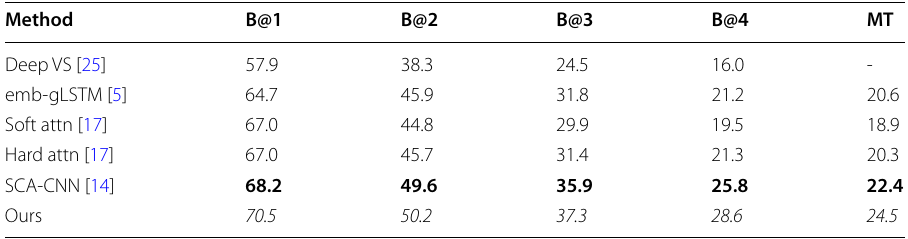
Table 5 Performance comparison of the proposed method on Flickr8K dataset. The best two models having larger values of the metrics are shown in red and